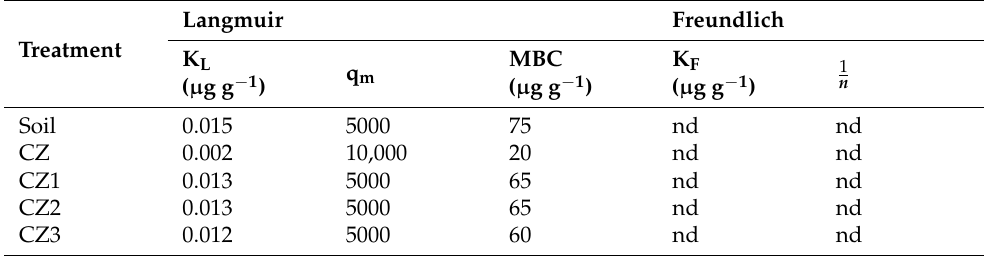
Table 17. Results from Langmuir and Freundlich isotherms for phosphorus adsorption by soil only, clinoptilolite zeolite only, and different amounts of clinoptilolite zeolite. Langmuir Treatment